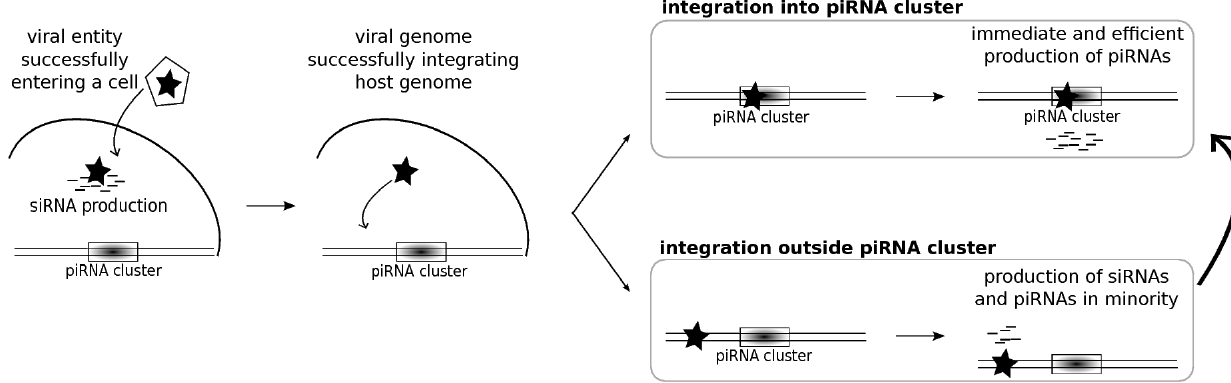
Figure 4. Schematic View of Small RNA Control Setup. Consider an RNA-based viral entity that managed to escape antiviral response, such as Toll, Imd or Jak-STAT